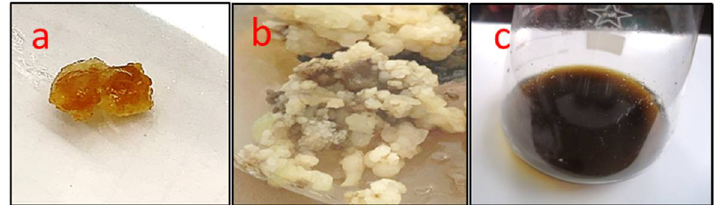
Figure 1. O. basilicum callus and cell suspension in MS and LS medium containing kinetin (0.5 mg/L), NAA (0.1 mg/L), 2,4-D (0.1 mg/L), and IBA (1 mg/L) and 3% ( w / v ) sucrose; ( a ) callus induction after seven days, ( b ) callus induction after 25 days, and ( c ) cell suspension after 40 days via somatic embryogenesis . NAA: 1-Naphthaleneacetic acid; 2,4-D: 2,4-Dichlorophenoxyacetic acid; and IBA: Indole butyric acid.